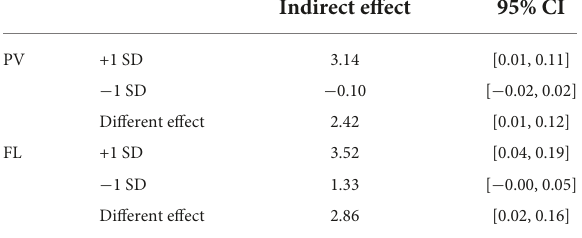
TABLE 4 The results of moderated mediation.